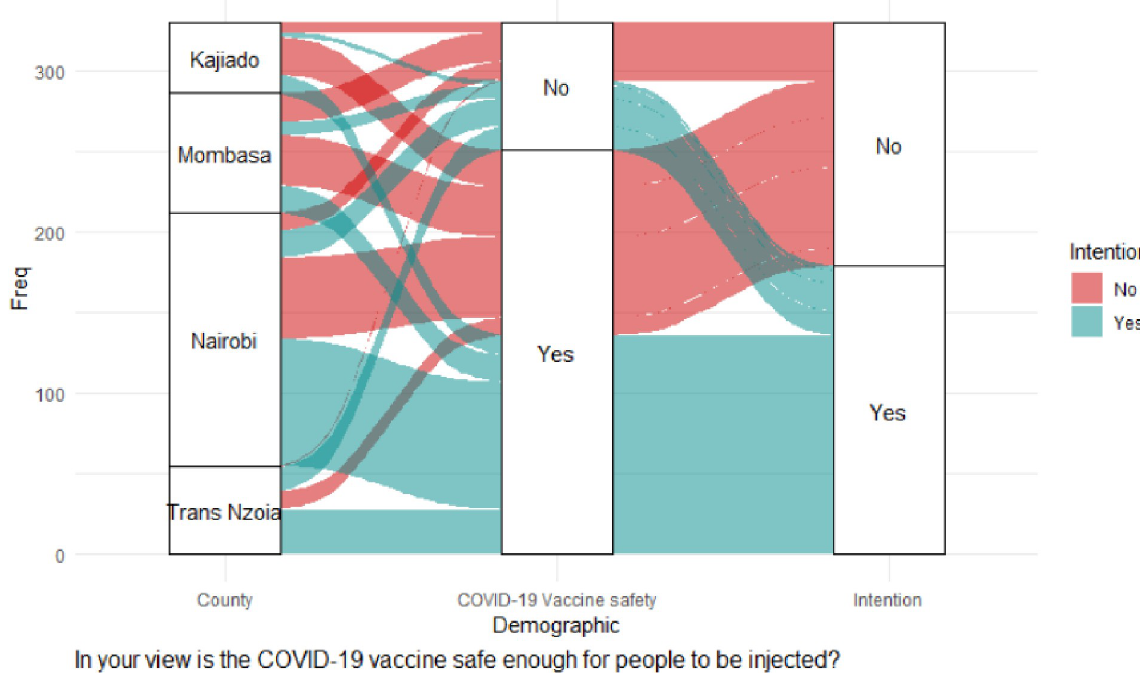
Fig 4. Belief in vaccine